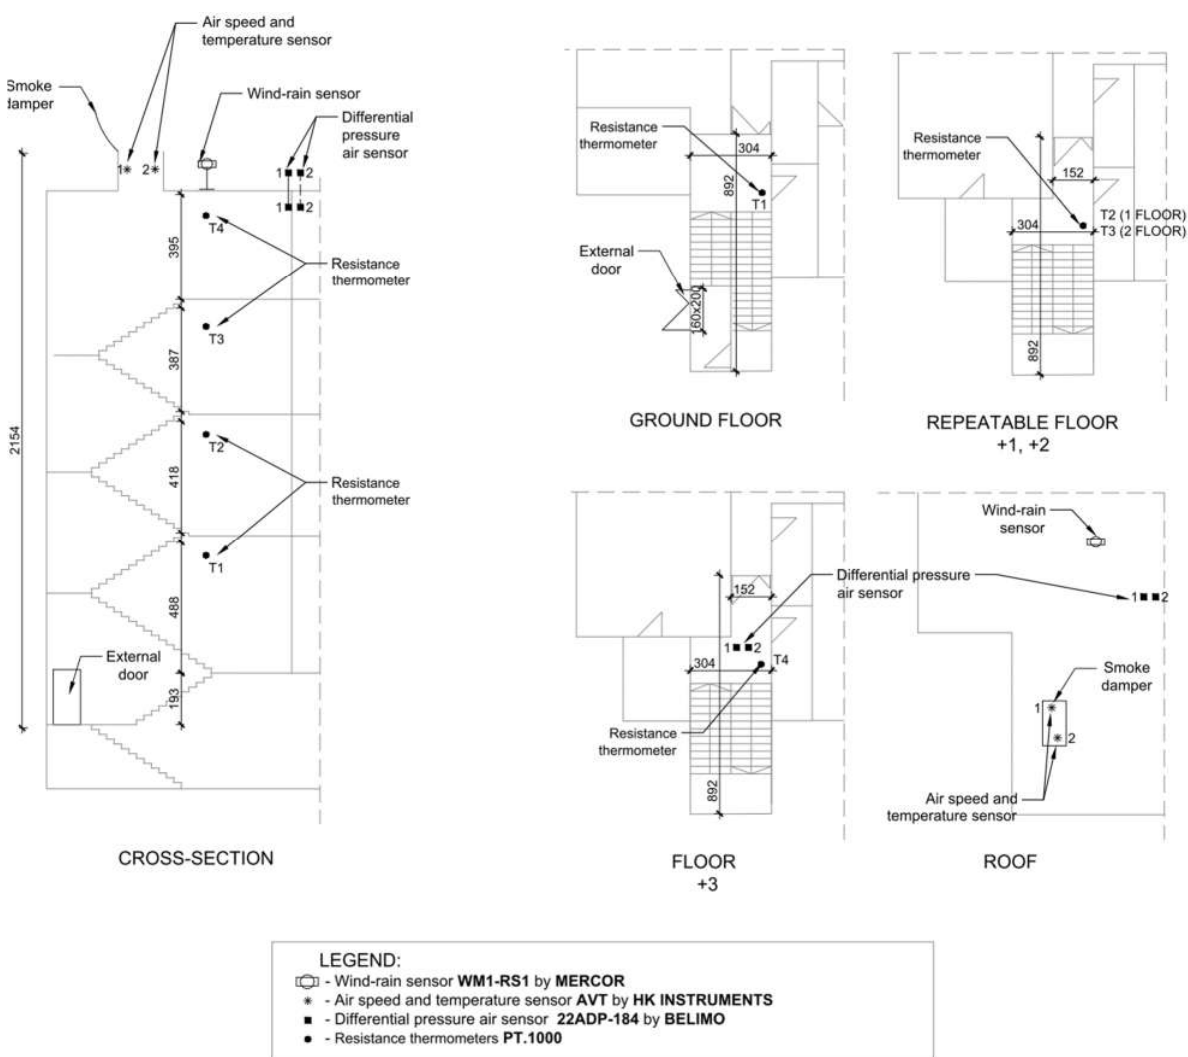
Figure 3. A diagram of the measuring station in the tested staircase (all dimensions shown in the drawing are specified in